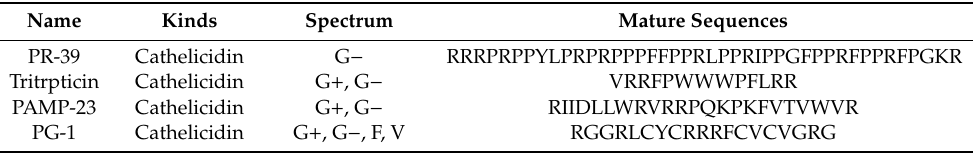
Table 1. The information of four antimicrobial